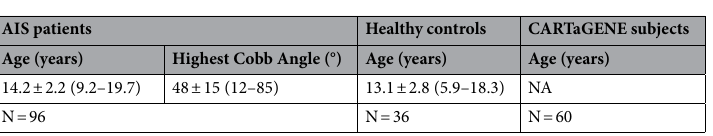
Table 2. Clinical and demographic characteristics of the participants in the first replication